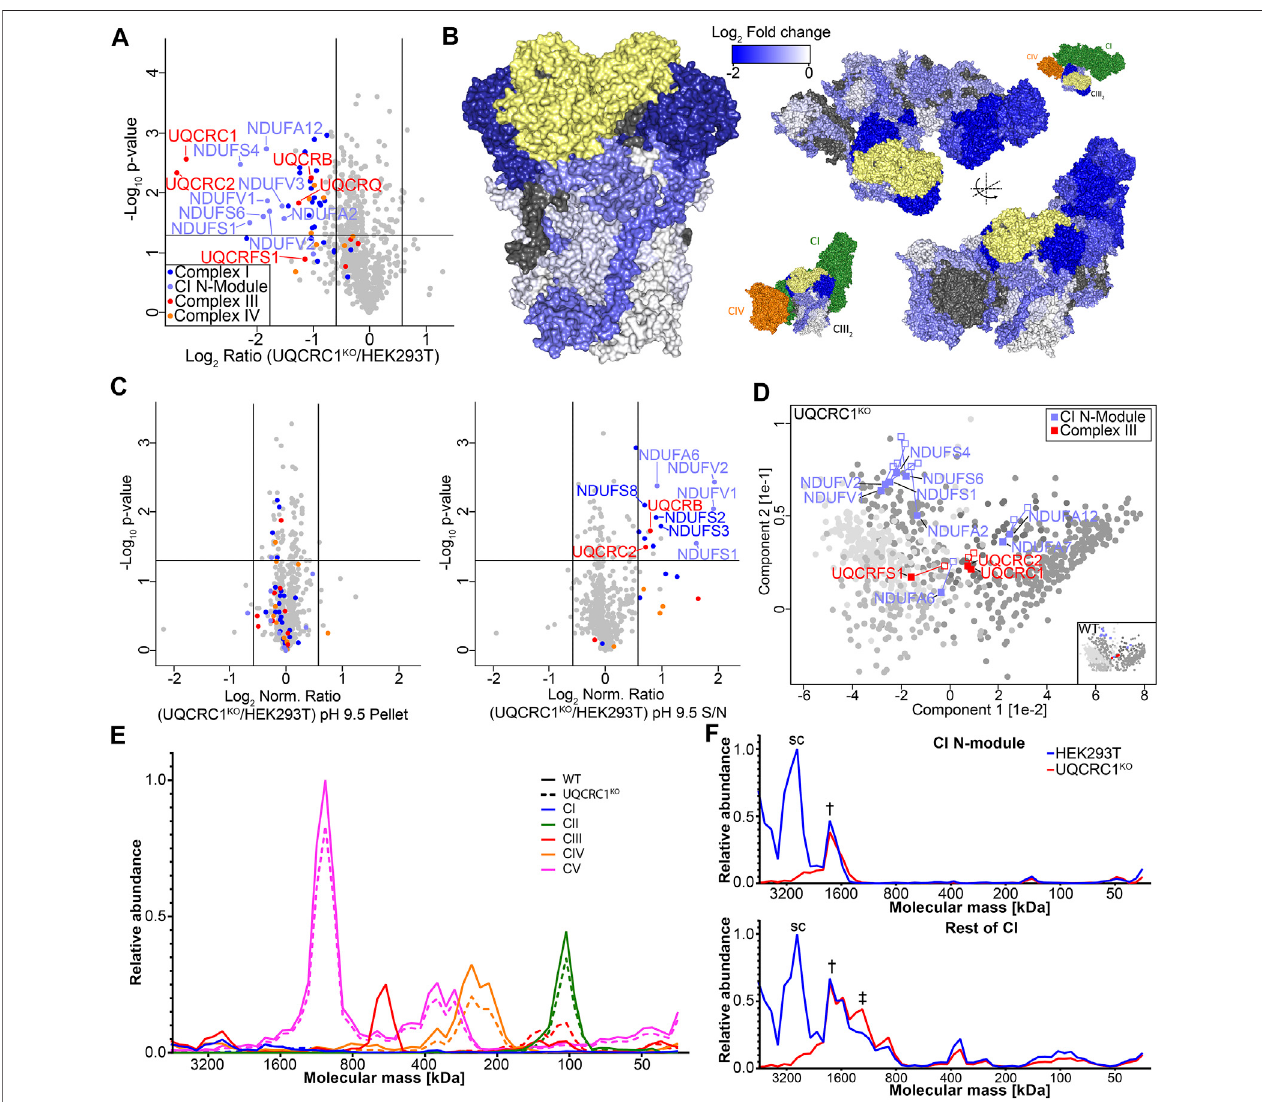
FIGURE 4 | Loss of UQCRC1 destabilizes the N-module of complex I. (A) Volcano plot depicting relative abundances of mitochondrial proteins in UQCRC1 KO compared to HEK293T. (B) Topographical heatmap showing changes in abundance of CIII and respirasome subunits in UQCRC1 KO using the CIII (PDB 5XTE) and respirasome (PDB 5XTH) structures. UQCRC1 shown in yellow (C) Volcano plots depicting relative abundance of proteins in pH 9.5 carbonate extraction pellet and supernatant fractions in UQCR10 KO compared to HEK293T mitochondria following normalization against the total fraction. (D) Principal component analysis showing overall membrane association pro fi les in UQCRC1 KO relative to control mitochondria. Complex I N-module and CIII subunits are labeled, with their position in control data shown as empty squares and position in knockout data as fi lled squares. Clusters de fi ned in Figure 2A are colored in grey. (E) Complexome pro fi le of mitochondrial respiratory complexes in UQCRC1 KO and HEK293T mitochondria. Graphs plot relative intensities of peptides averaged across all subunits of each complex with the maximum set as 1.0. Molecular mass calculated as described in Materials and Methods . (F) Complexome pro fi le of CI subunits, separated into N-module and the rest of the complex, as in (E) . The symbols used to indicate peaks represent the equivalent complex in Figure 3A .